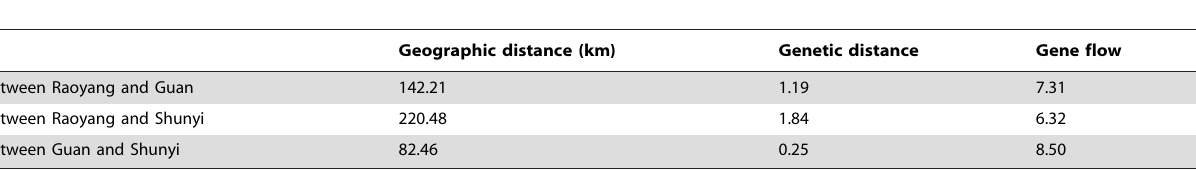
Table 2. The geographic distance the genetic distance and the gene flow among the three examined geographic populations of the Greater long-tailed